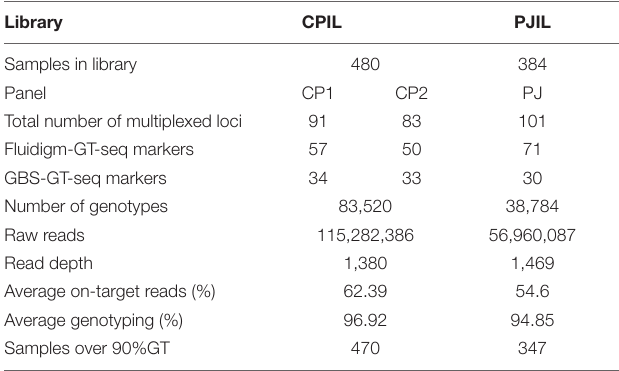
TABLE 5 | Summary of GT-seq results when mixing GBS-GT-seq markers and Fluidigm-GT-seq markers in the Nextseq platform. Library CPIL